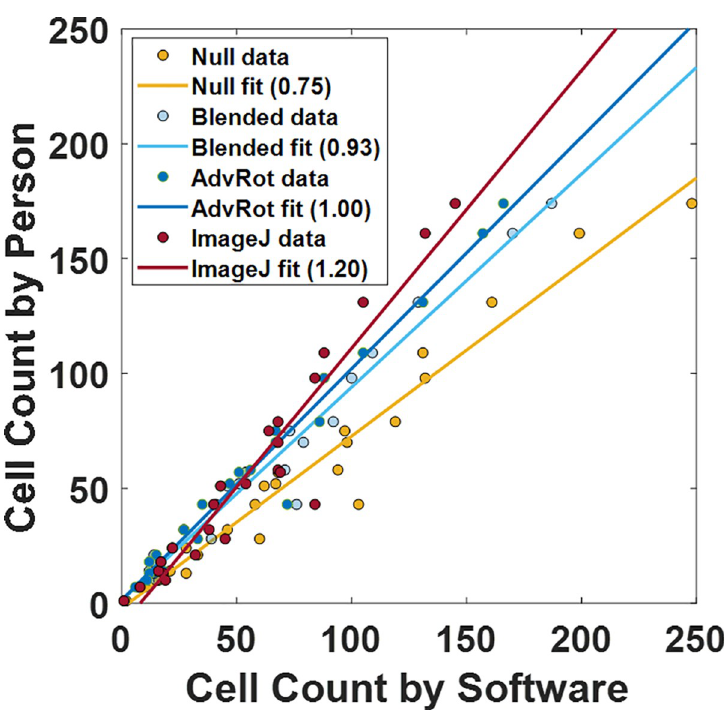
Fig 5. Comparing accuracy of manual (same person, average of 3 counts) to software (cCNN or ImageJ) counting methods (Supplement 13 in S1 File ). Each point represents an evaluated image. The units are the number of cells per